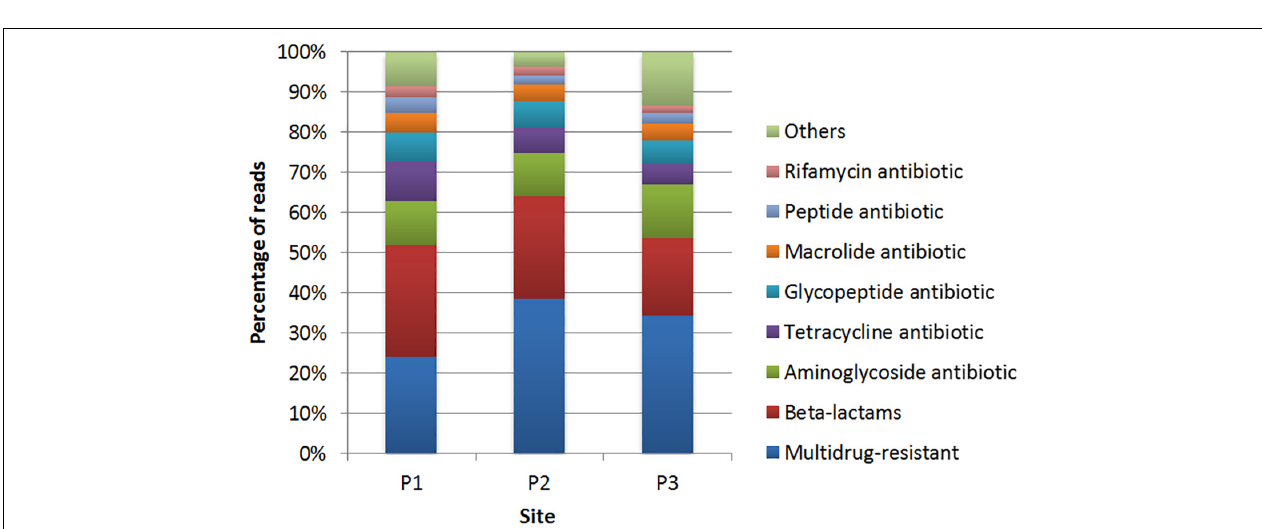
FIGURE 5 | Distribution of the genes conferring resistance to different classes of antibiotics identified by comparison with the CARD database at sites P1, P2, and P3.